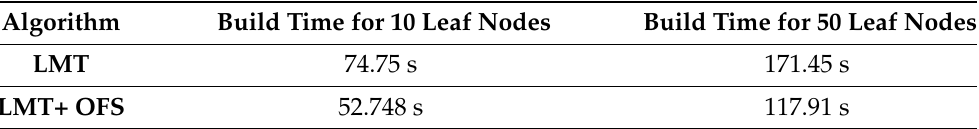
Table 6. Run time for the different algorithms for trees of different